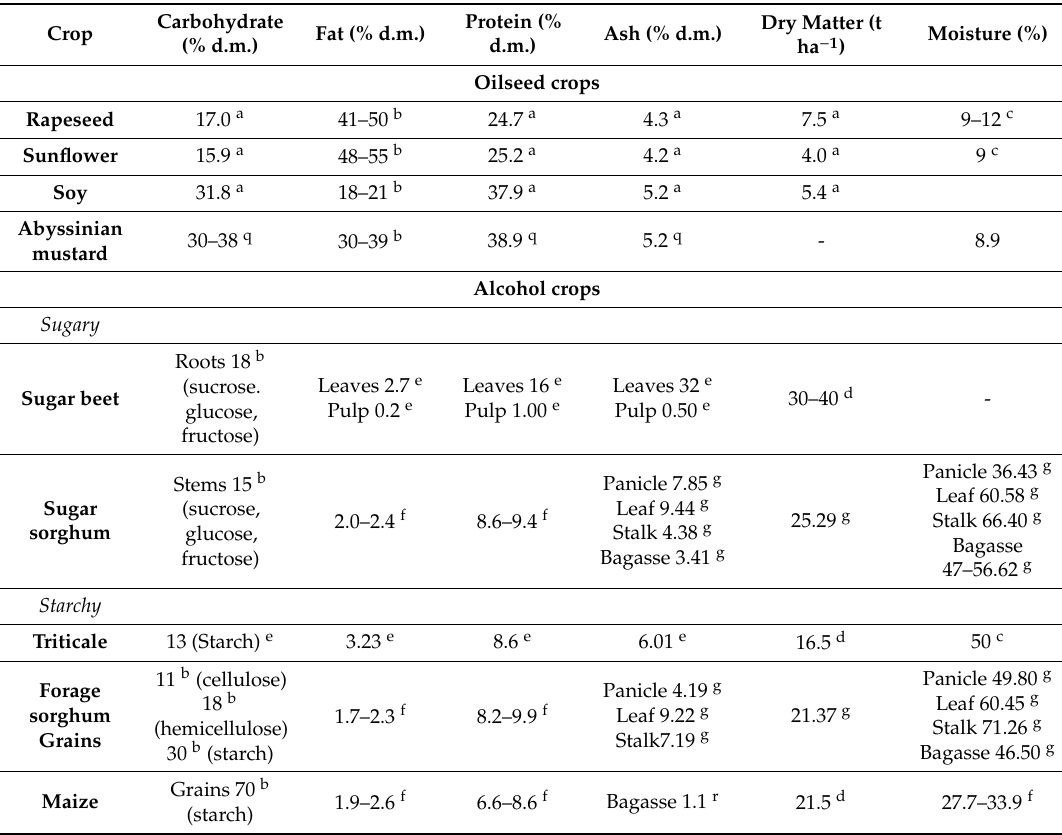
Table 3. Chemical composition of energy